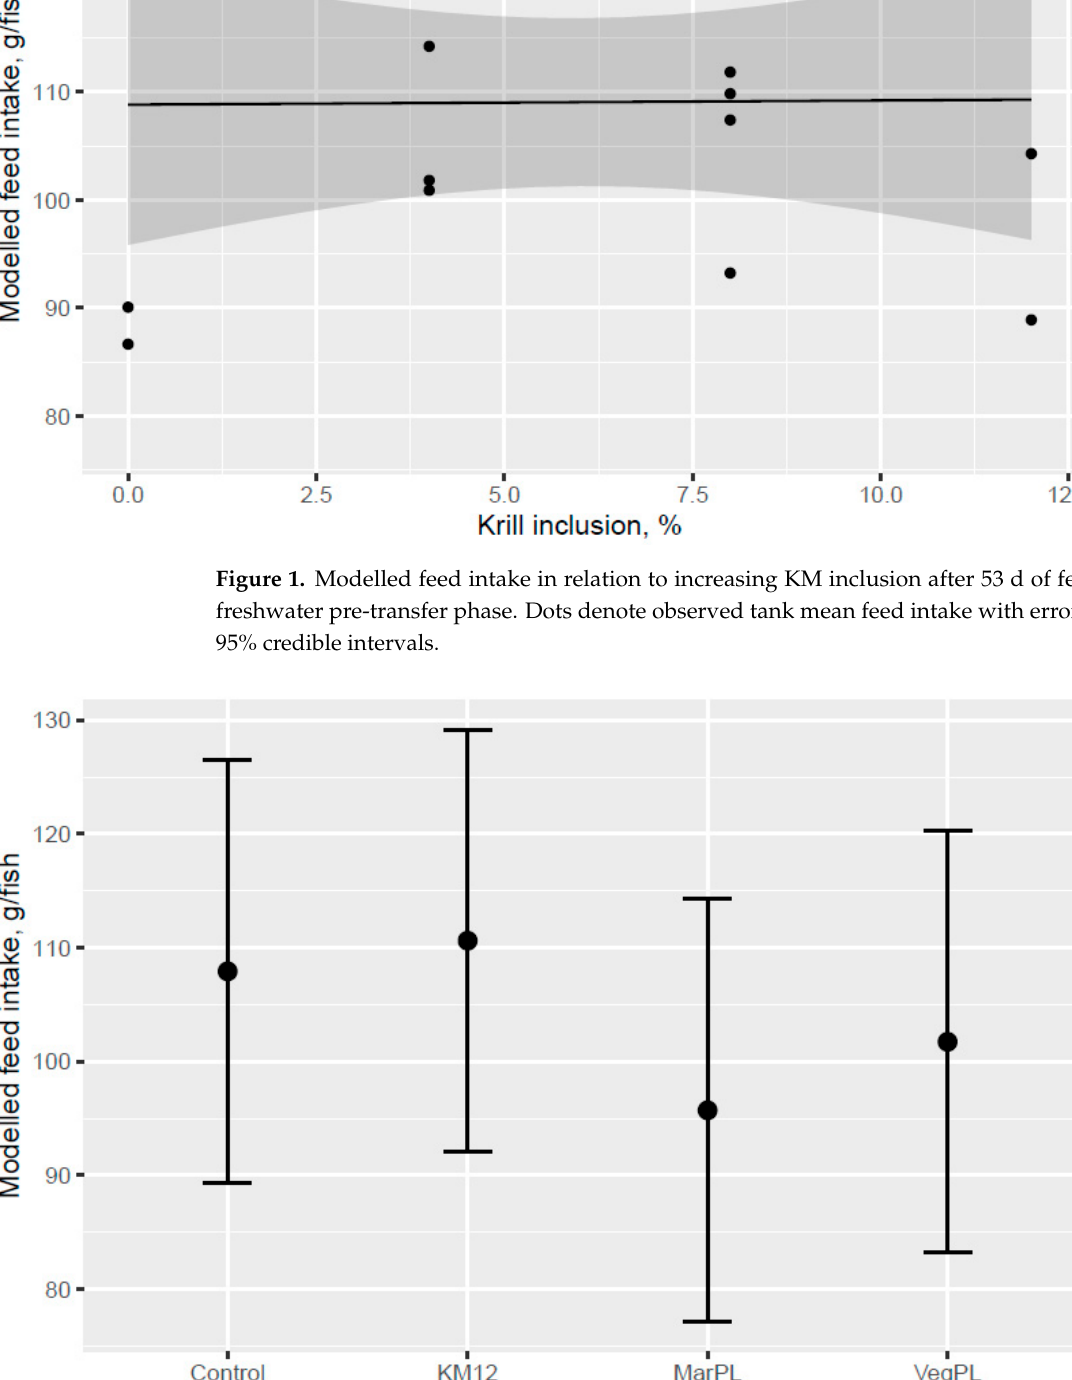
Figure 2. Modelled feed intake for diets containing different phospholipid sources after 53 d of feeding in the freshwater pre-transfer phase. Dots denote observed tank mean feed intake with error bars giving 95% credible intervals.